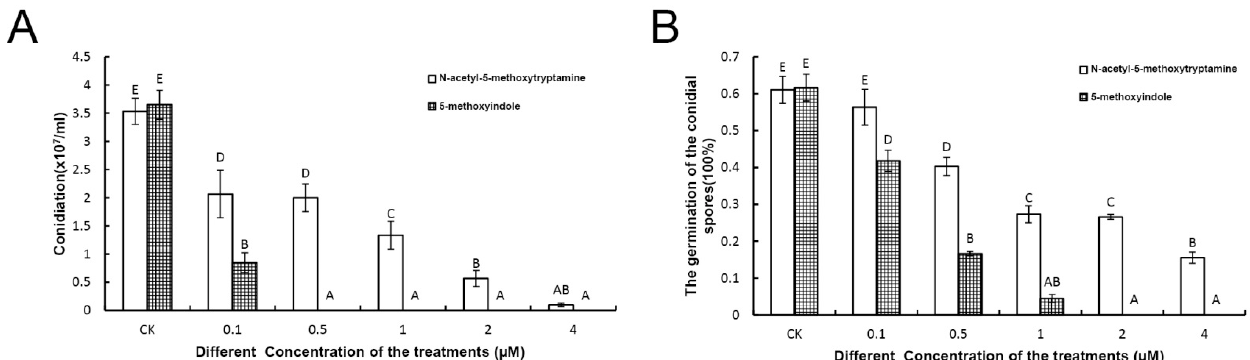
Figure 2. Analysis of F. graminearum PH-1 conidiation treated with different concentrations of melatonin and 5-methoxyindole ( A ). The conidial spore germination of F. graminearum after being treated with the different concentrations of melatonin and the 5-methoxyindole ( B ). The experiment was repeated independently three times, and 0.05% (vol/vol) methanol/water served as the ck. The error bars represent the mean standard deviation of each treatment repeated three times with three replicates. The letters above the columns indicate significant differences. The significant difference between the treatments was determined through Tukey’s HSD test at p ≤ 0.05.